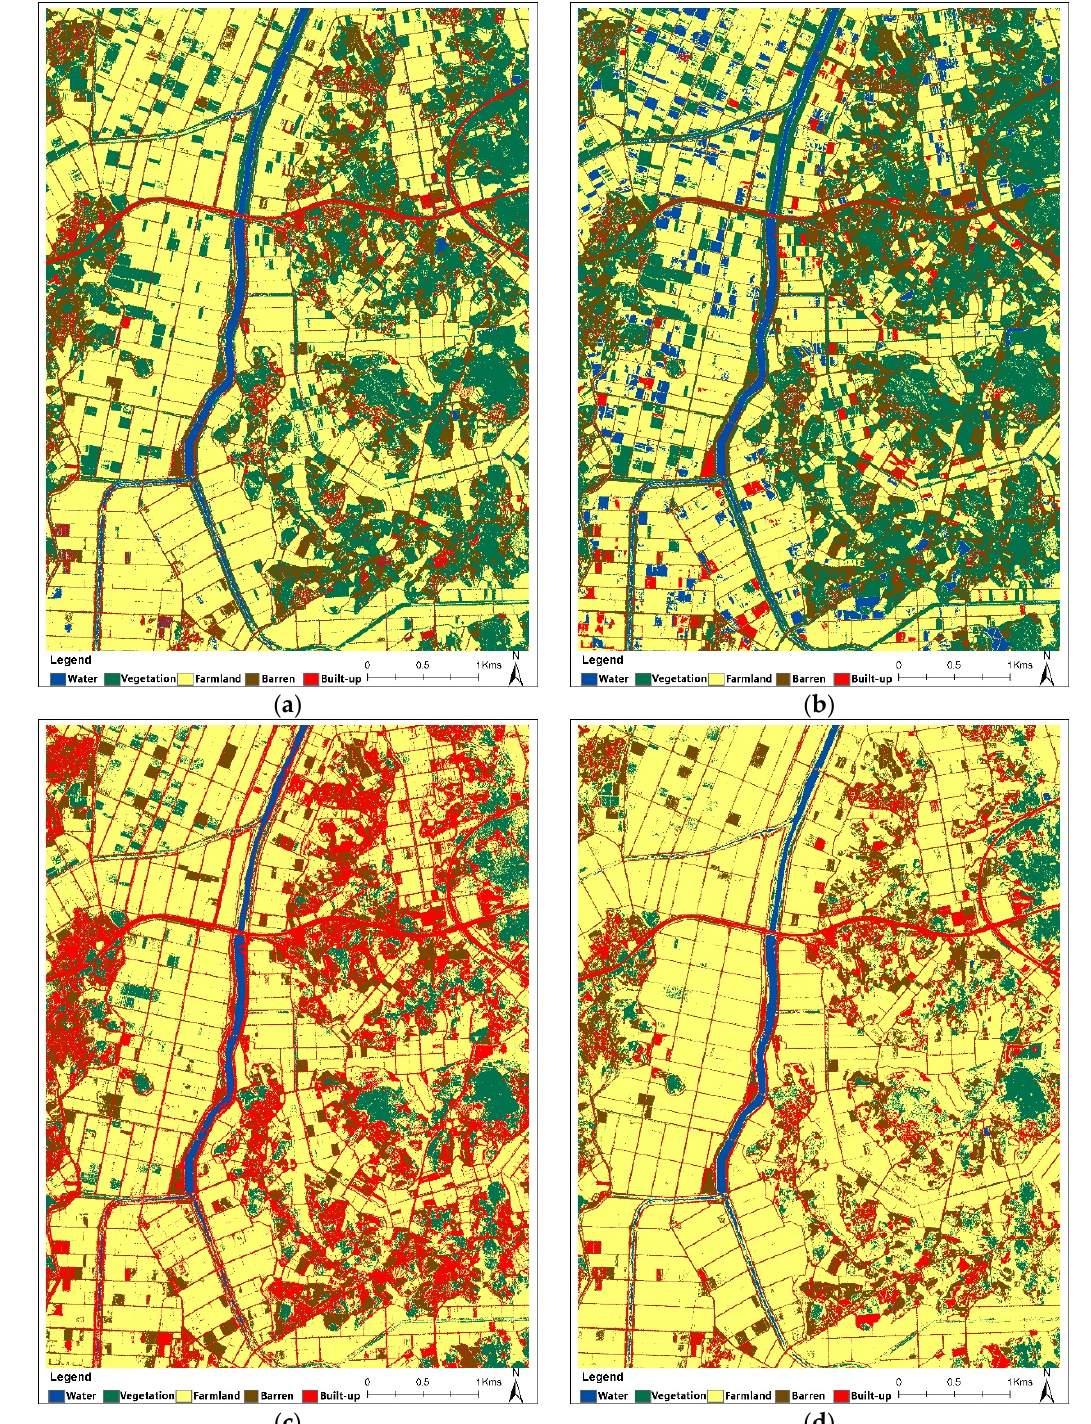
Figure 5. Land cover classification of the test site using original four bands composite: ( a ) Mahalanobis Distance (MahD); ( b ) Minimum Distance (MinD); ( c ) Maximum Likelihood (ML); and ( d ) Support Vector Machine (SVM).